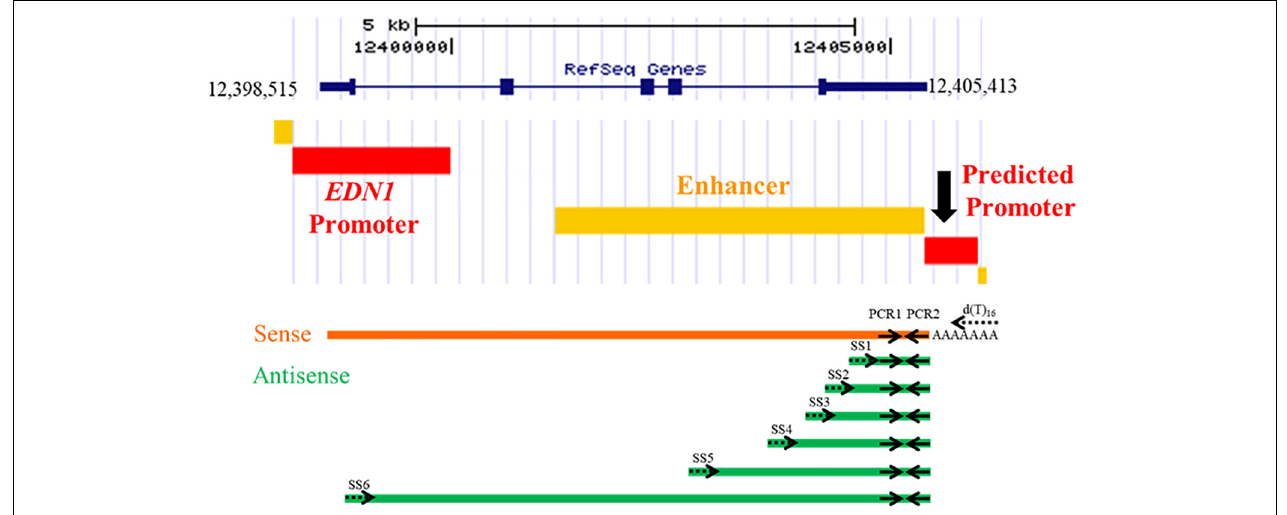
FIGURE 3 | Strand-Specific Reverse Transcriptase PCR Reactions. Strand-specific reverse transcriptase (RT) PCR reactions were designed using primers that would only anneal to an antisense transcript to EDN1 . A total of 6 different strand-specific primers were used in the RT reactions (SS1–SS6, dotted arrows), which were progressively further away from the predicted 3 (cid:48) UTR promoter region. For a positive RT control, oligo dT primers were used as it is known EDN1 mRNA is poly-adenylated. After conversion of RNA into cDNA, PCR1 and PCR2 primers (solid arrows) were used in a PCR reaction to amplify any products generated. PCR1 and PCR2 amplify the same piece of cDNA regardless of the strand-specific primer used, so all bands visualized by gel electrophoresis are the same size (165